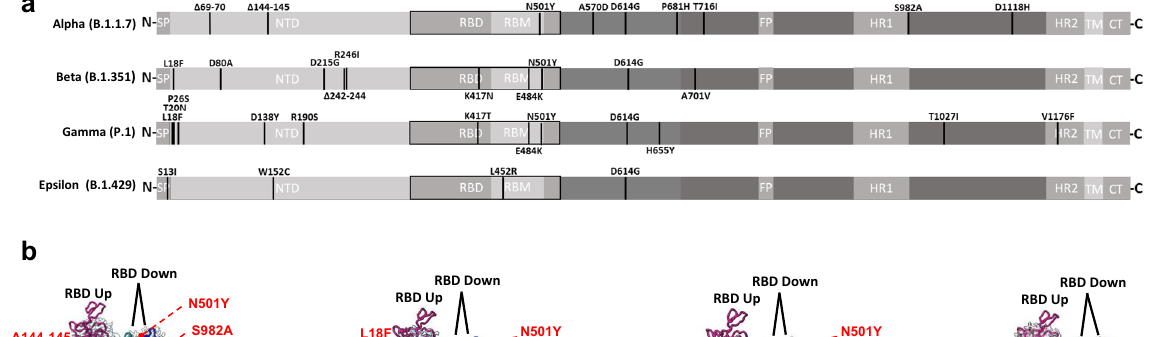
2,TMtransmembrane,CTcytoplasmictail). b Globalcryo-EMmapsandmodelsfor the Alpha (2.56Å), Beta (2.56Å), Gamma (2.25Å), and Epsilon (2.4Å) variant S proteins. Mutational positions are indicated and labeled in